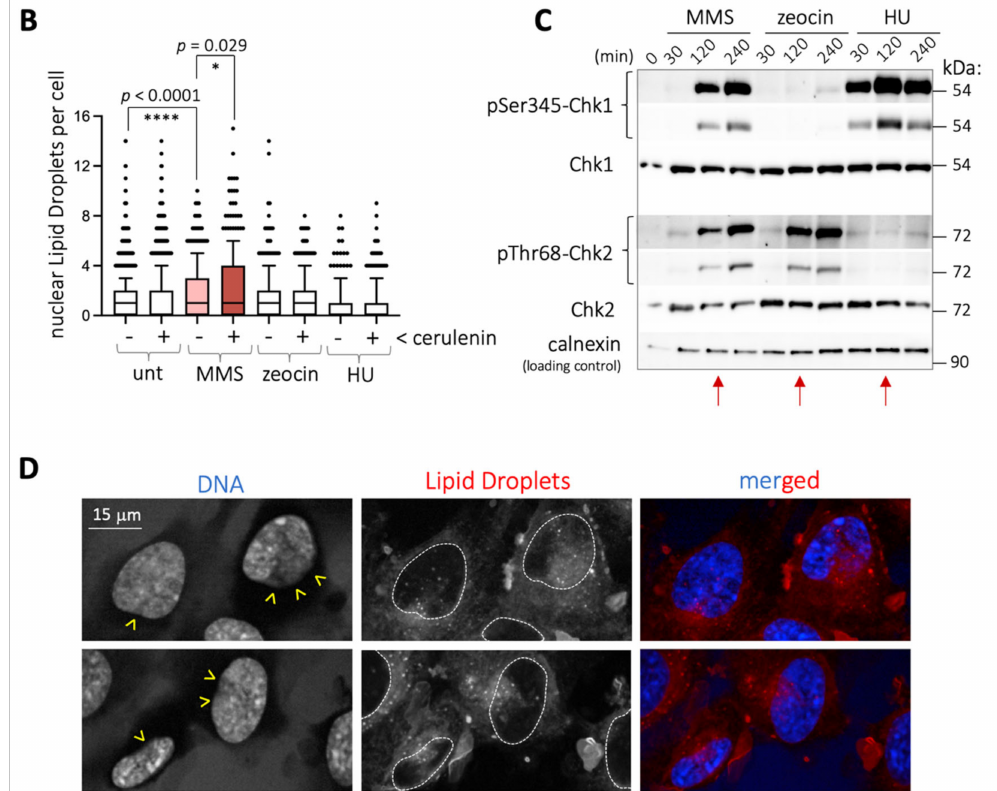
Figure 1. MMS triggers the formation of nuclear LD in RPE-1 cells. ( A ) Microscopy images corresponding to RPE-1 cells treated for 2 h with 0.005% MMS. Nuclei are identified by staining DNA with DAPI, and LD with the vital dye NileRed. To facilitate visualization of the respective position of the LD within the nucleus, merged images are shown at the bottom, and the perimeter of nuclei superimposed as dashed lines onto the LD images. ( B ) Quantification of the number of nuclear LD counted in RPE-1 cells upon treatment with the indicated agents. When cerulenin is indicated, it was added at 5 µ g/mL to the cultures for 4 h, plus the incubation or not with 0.005% MMS, 100 µ g/mL zeocin or 1 mM HU during the last 2 h. Each dot corresponds to the value noted for one nucleus. At least 200 nuclei per experiment and condition were counted from 3 independent experiments. The boxes comprise the 10–90 percentile values, and their central bar represents the median of the population. Since populations were not normally distributed, the significance of differences between the populations is indicated by asterisks (*) and their associated p -values, obtained after applying a Mann–Whitney nonparametric test. ( C ) Western blot of extracts from RPE-1 cells untreated or treated with either 0.005% MMS, 100 µ g/mL zeocin or 1 mM HU for the indicated times to monitor the activation of the DDR by following the phosphorylation on Serine 345 (pSer345) of the effector Chk1 and that of Chk2 on threonine 68 (pThr68). Molecular weights are shown in kDa as indicated by co-run molecular weight ladders. Red arrows mark the samples chosen for the microscopy studies shown in ( B ). ( D ) Details as in ( A ) for cells treated 4 h with cerulenin at 5 µ g/mL, and then 0.005% MMS added during the last 2 h. Dashed white lines define the nucleus boundaries. Yellow arrowheads point at the locations of the nuclei periphery from which LD are seen to access the nucleus, eventually preventing the DAPI